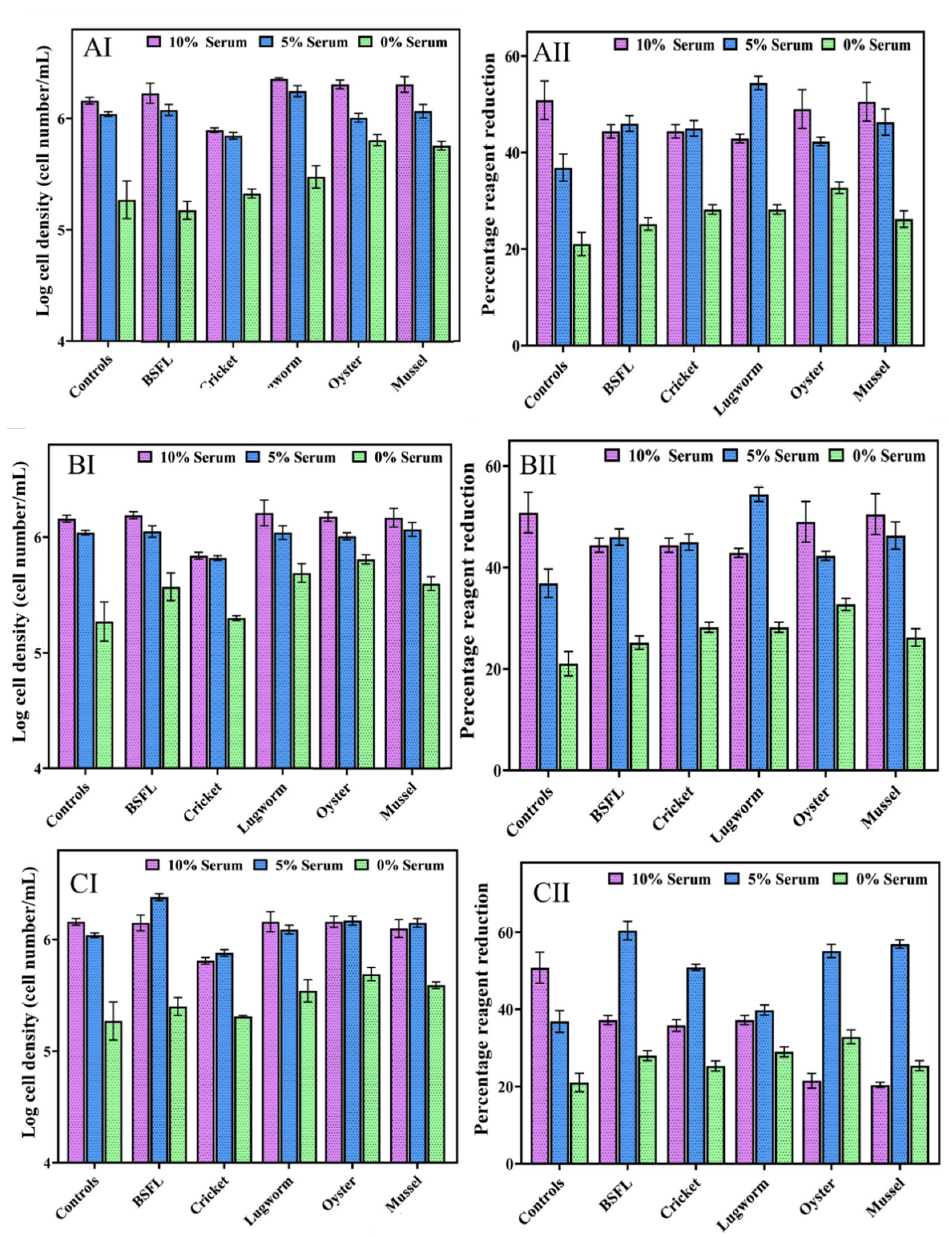
Figure 4. ZEM2S cells’ growth in media containing different serum concentrations (10%, 5% and 0%), ( A ) 0.1 mg/mL protein hydrolysates (AI: cell growth; AII: cell viability); ( B ) 0.01 mg/mL protein hydrolysate (BI: cell growth; BII: cell viability); and ( C ) 0.001 mg/mL protein hydrolysates (CI: cell growth; CII: cell viability).